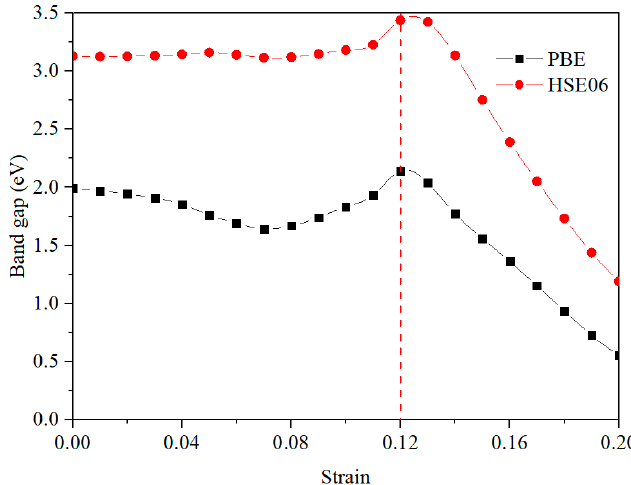
Figure 5. PBE and HSE06 band gap-strain curves of the CO 2 adsorbed g-C 3 N 4 system.